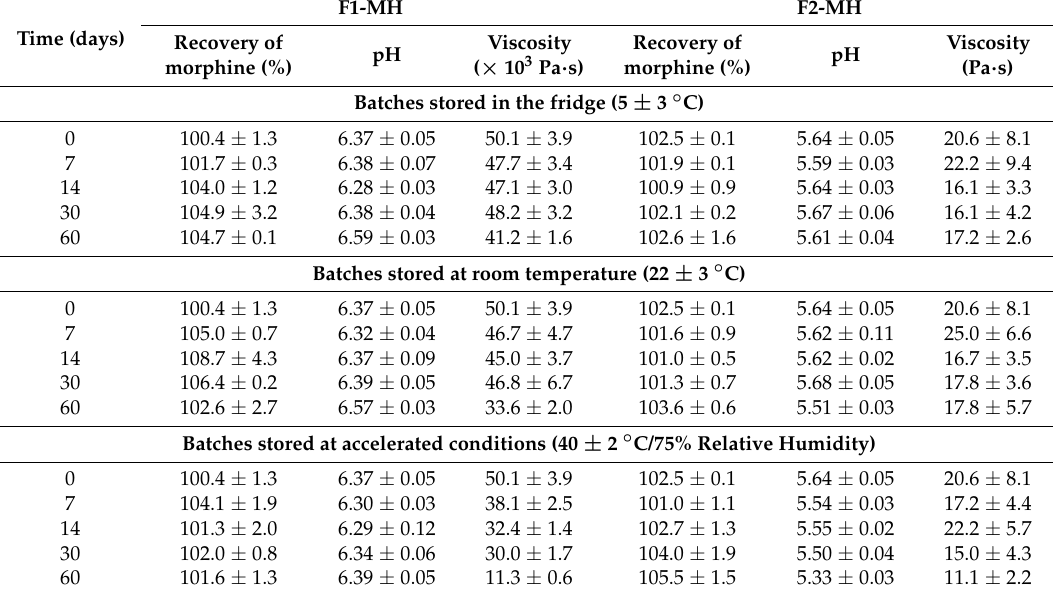
Table 5. Physicochemical stability of semi-solid (F1-MH) and fluid (F2-MH) morphine-containing hydrogels stored protected from light, at different temperatures (mean ± SD, n = 3).